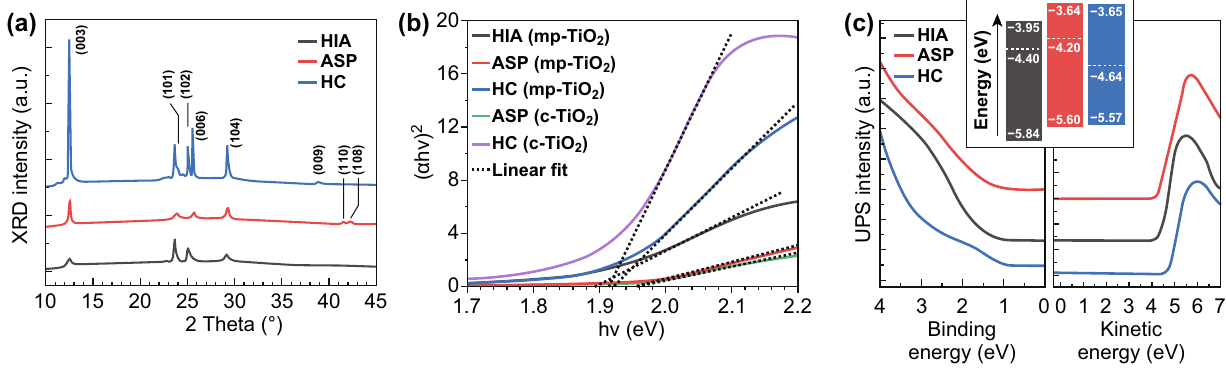
Fig. 2 a XRD patterns, b Tauc plots, and c UPS intensity (valence band states (left) and He I secondary electron onset (right)) from Ag 2 BiI 5 layers fabricated using the different processing methods detailed in the text. Inset of c : energy levels of the layers deposited through the different